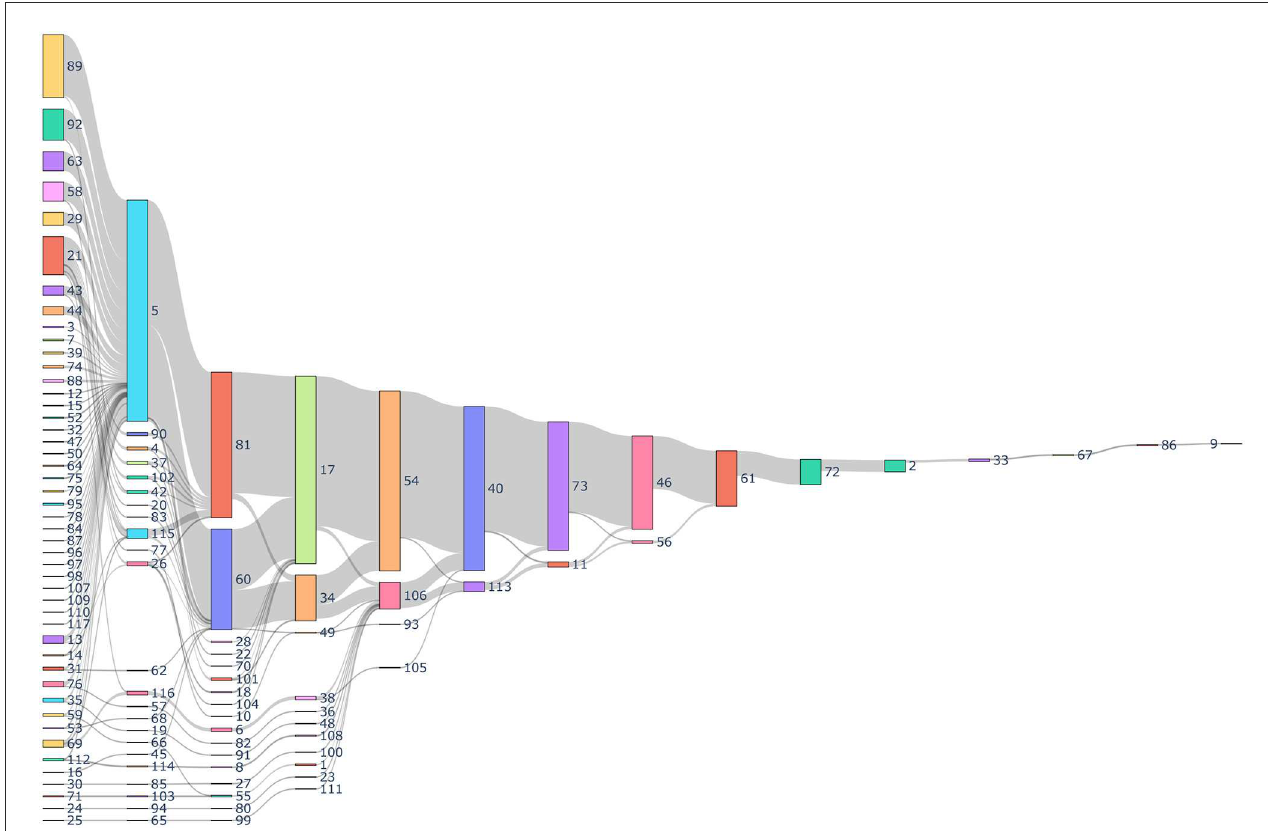
FIGURE4 Sankey diagram depicting the history of data collection through different forms. Every number indicates a unique identification indicating the form and the sequence in which it was collected for a patient. The gray links represents the number of patients. The size of the nodes represent the number of total forms